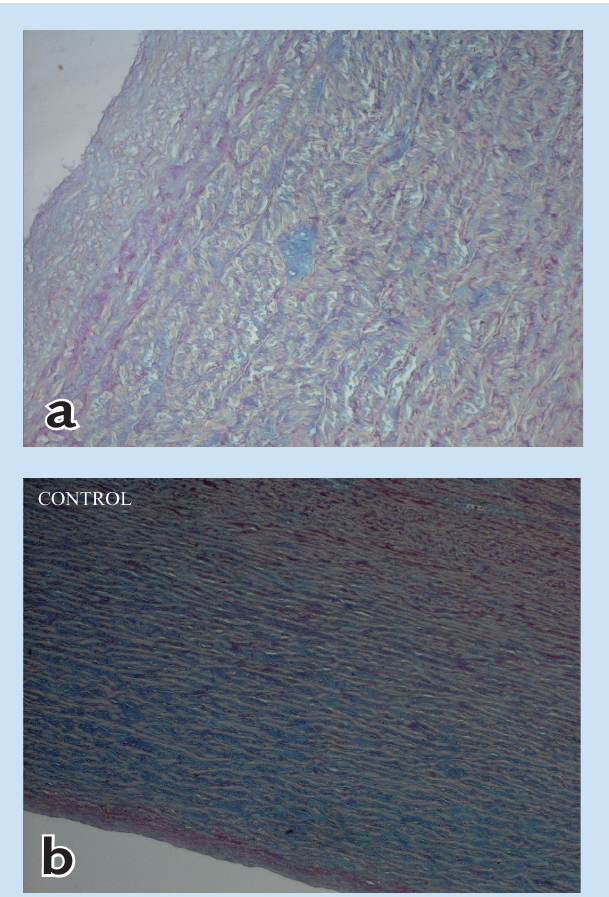
Figs. 7a (patient) and 7b (control) (microscopy). Microscopic specimen of aortic wall using an Alcian Blue stain to demonstrate intimal and medial accumulations of mucoid material, relative to an age-matched